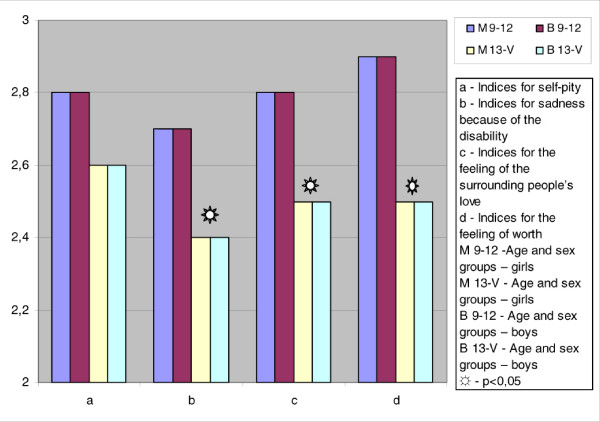
The self-worth index of schoolchildren with disabilities by age and sex. The relationship of the values of the respondents' self-worth index (self-pity, sadness because of the disability, the feeling of the surrounding people's love, the feeling of worth) with their age and sex (girls, boys).